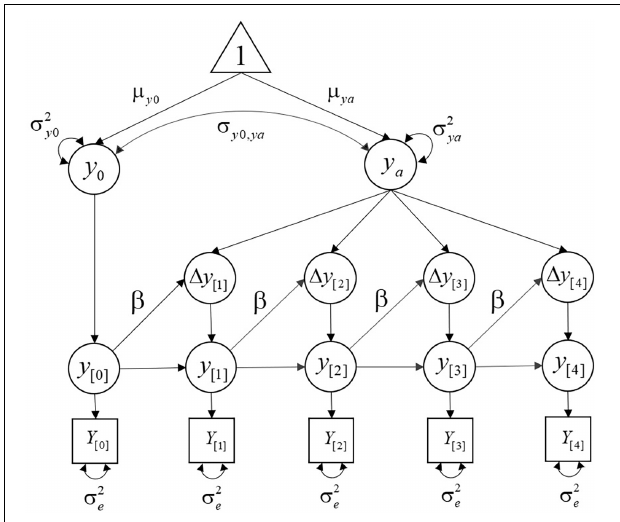
FIGURE 1 | Univariate dual LCS model with five measurement occasions. Unnamed paths have weights of